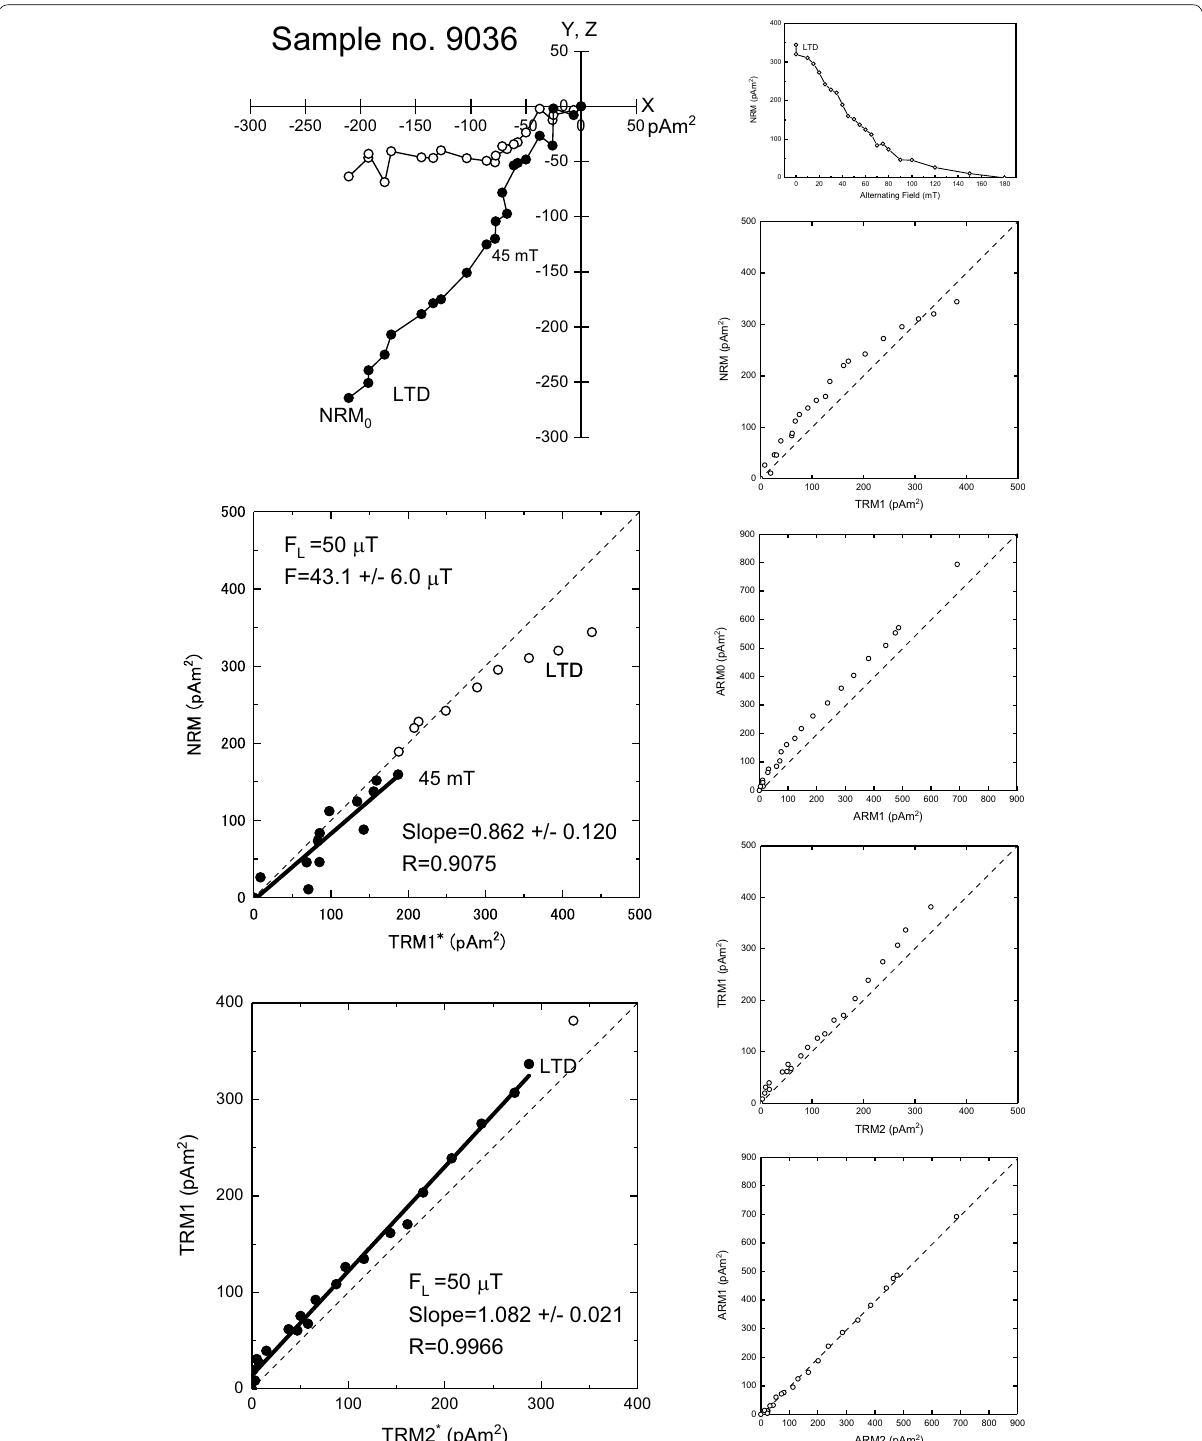
Fig. 8 A representative result of successful paleointensity measurements by the Tsunakawa–Shaw method on single plagioclase grain. The dotted line indicates where the horizontal and vertical axes are equal. In the orthogonal plot, open and closed circles indicate X – Y and X – Z planes,